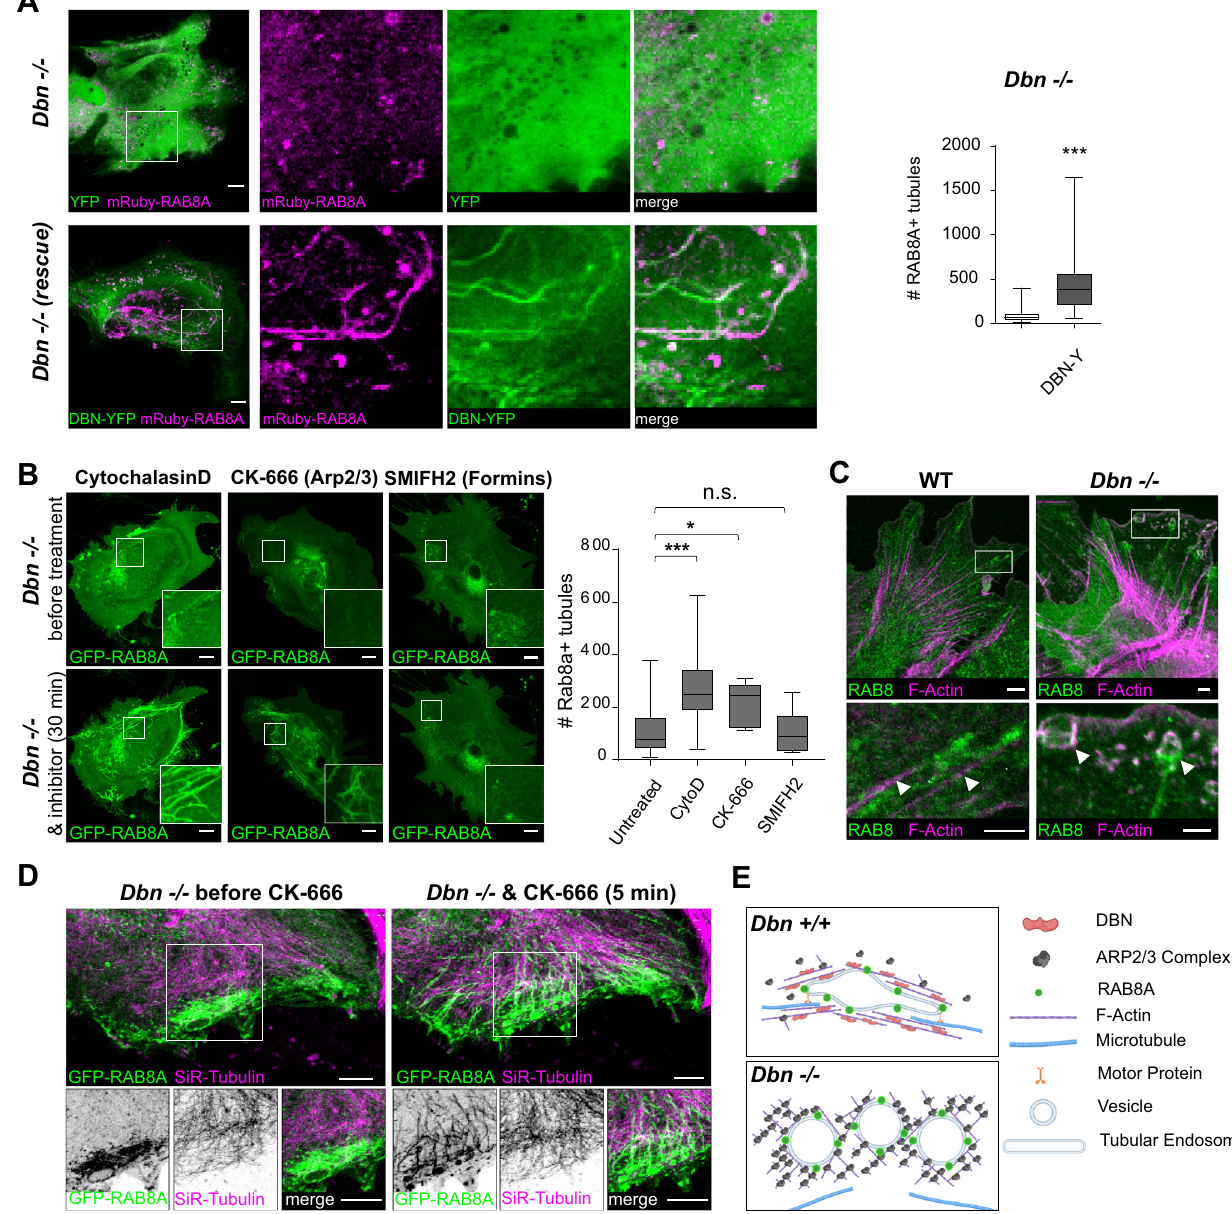
Fig. 4 DBN balances the actin nucleation machinery during RAB8A tubule formation. A DBN rescues RAB8A membrane tubules in Dbn − / − astrocytes. Dbn − / − astrocytes co-transfected with mRuby-RAB8A and YFP-control (upper panels), or with mRuby-RAB8A and DBN-YFP (bottom panels). Scale bars: 10 µ m. Images are confocal stacks. Quanti fi cation of mRuby-RAB8A tubules displayed as box and whisker plots: box extends from 25th to 75th percentiles, central line = median, whiskers comprise all values from minimum to maximum; n = 63 – 65 cells from three independent experiments ( F test for equal variances *** P < 0.0001, Unpaired t test with Welch ’ s correction, two-sided, *** P = 0.000000000025, t = 7.965 df = 68.19). B Live imaging of Dbn − / − astrocytes expressing GFP-RAB8A before (upper panels) and 30 min after treatment with different inhibitors (lower panel); 100 nm Cytochalasin D (left), 100 µ m CK-666 (center), or 25 µ m SMIFH2 (right). Scale bars: 10 µ m. Images are confocal stacks. Graph shows the quanti fi cation of GFP-RAB8A tubules 30 min after inhibitor treatment, Cytochalasin D, n = 16; SMIFH2, n = 8; CK-666, n = 9 cells; all from three experiments. Box and whisker plots: box extends from 25th to 75th percentiles, central line = median, whiskers comprise all values from minimum to maximum (one-way ANOVA F = 11.47, DFn = 3, DFd = 63, Dunnett ’ s multiple comparisons test, multiplicity adjusted p values: * P = 0.01534048, *** P = 0.0001, ns P = 0.9999). C Distribution of endogenous RAB8A (green) and F-Actin (magenta) in WT (left panel) and Dbn − / − (right panel) astrocytes. Arrowheads in WT panel indicate RAB8 + tubules aligned with actin fi bers. In the Dbn − / − panel, arrowheads highlight RAB8 + membrane cisterns. Representative images from three different experiments. Scale bars: 10 µ m. Images are single confocal sections. D Dbn − / − astrocytes expressing GFP-RAB8A and labeled with SiR-tubulin before (left panel) and 5 min after adding 100 µ M CK-666 (right panel); see Movie 7. Scale bars: 10 µ m. RAB8 + tubules formed immediately after adding CK-666 and aligned with adjacent microtubules, while extending into the cytosol. Representative images showing the effect observed by CK-666 treatment in three independent experiments. Images are single confocal sections. E Proposed mechanism.: DBN functions as an essential switch in the actin network homeostasis, which supports the formation of RAB8A + tubular endosome along microtubules. Source data are provided as a Source Data fi